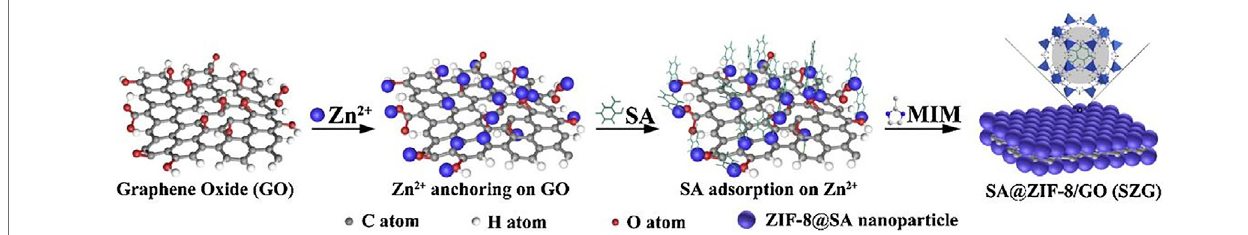
FIGURE 14 | Synthetic procedure illustration of SZG (Xiong et al., 2019b).